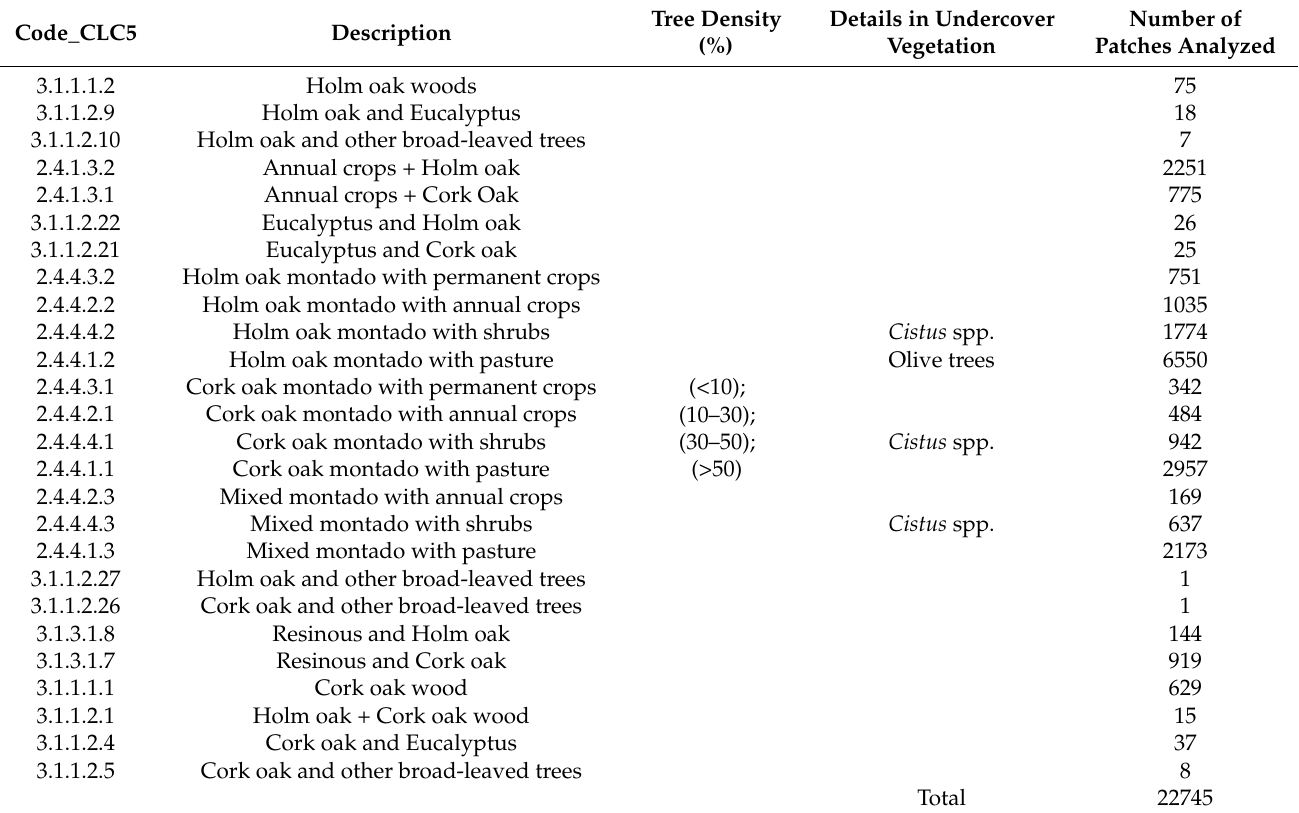
Table 1. Extract from the legend Corine Land Cover level 5 (CLC5), details and number of patches